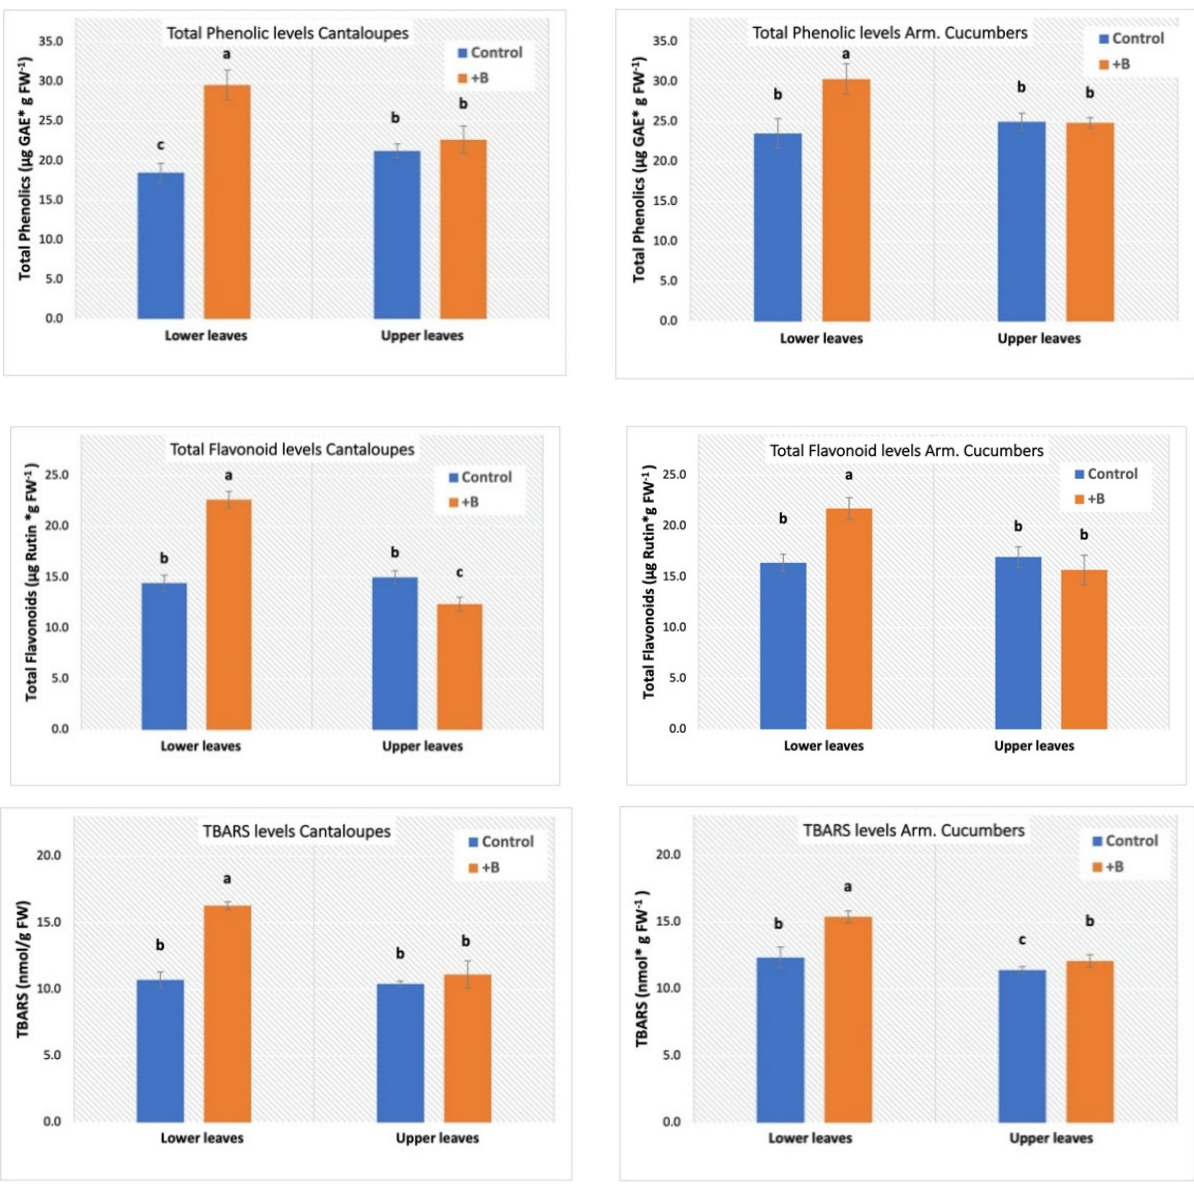
Figure 3. Effect of the oversupply of B (by using H 3 BO 3 ) on total phenolic, total flavonoid and thiobarbituric acid reactive substances’ (TBARS) contents of young (close to the apical meristem) and mature (close to the root-to-shoot intersection) leaves of cantaloupes ( C. melo var. Cantalupensis cv. Retato Degli Ortolani) and Armenian cucumbers ( C. Melo var. flexuosus cv. Abruzzese Tortarello). Growth period lasted 35 d, where no visible B toxicity symptoms were apparent (Figure 1). Means followed by different letters indicate significant differences ( p = 0.05). Values are the mean of ten replications (± SD).